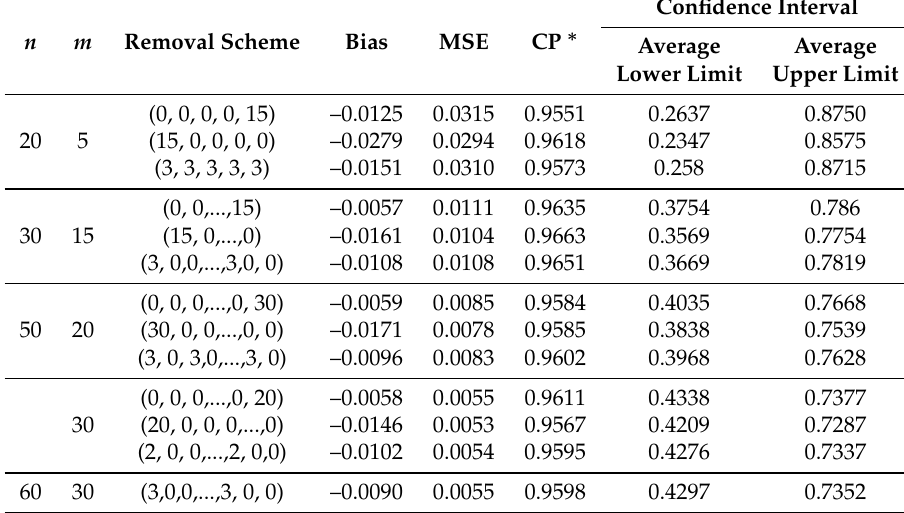
Estimation results of δ s , k using the parametric percentile bootstrap method